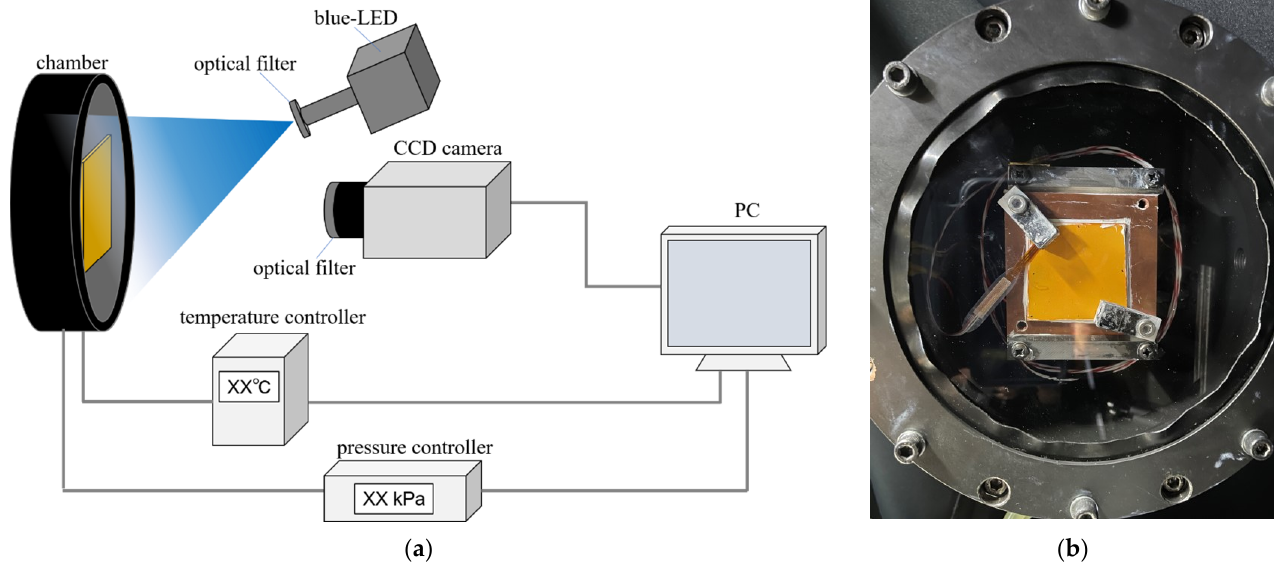
Figure 3. Pictures of a calibration system for TSP. ( a ) Schematic of components and their connections; ( b ) Picture of the chamber. Test piece is mounted in the chamber.